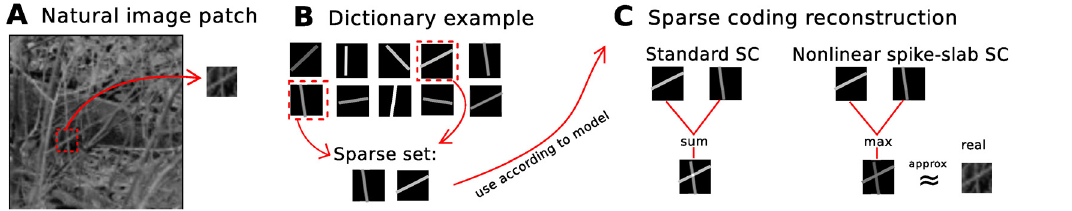
Fig 1. Toy example illustrating the problem setting: approximating occlusions in images. Given an image patch with occlusions ( A ), assume both the linear and nonlinear sparse coding models were given the true generating dictionary elements ( B ) and the task is for each model to use a sparse set of these to generate a reconstruction of the patch ( C ). A Example natural image with one patch to be reconstructed by the models. B 10 ground-truth dictionary elements, assumed to be known and with only 2 of 10 having generated the image patch. C Image reconstruction using the sparse dictionary set of the 2 models: the standard linear sparse coding model and the nonlinear spike-and-slab SC model. The linear sum leads to inaccurate pixel estimates when components overlap, whereas the nonlinear max aims to approximate this type of data more realistically in this scenario. Furthermore, the spike-and-slab prior (shown here for the the nonlinear model) allows the model to adapt the intensity of each image component to match what it observed in the data.